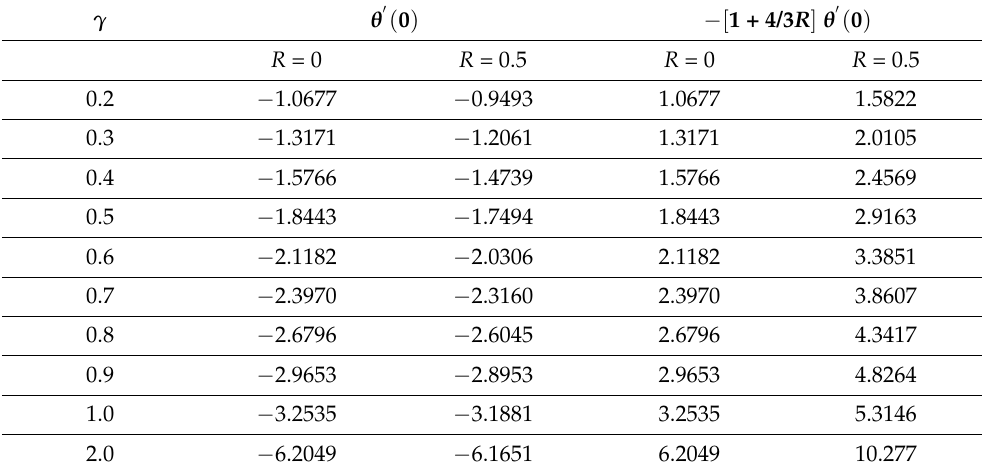
Table 10. Impact of curvature parameter on Nusselt number for non-radiative and radiative flow fields.